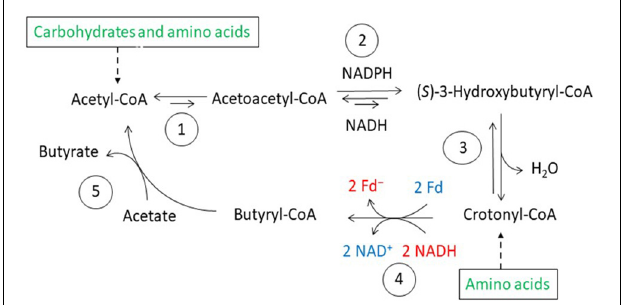
FIGURE 5 | Butyrate synthesis in anaerobic bacteria. 1, Thiolase; 2, ( S )-3-hydroxybutyryl-CoA dehydrogenases, NADH and NADPH specific; 3, ( S )-3-hydroxybutyryl-CoA dehydratase; 4, electron bifurcating EtfAB-butyryl-CoA dehydrogease complex; 5, butyrate